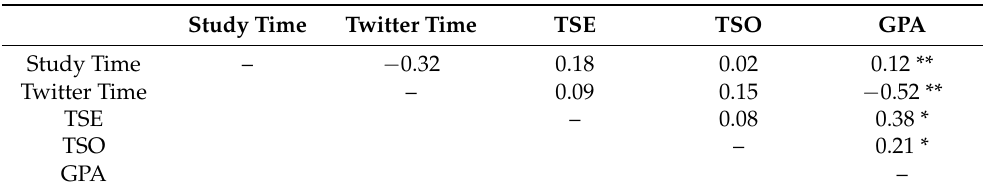
Table 4. Correlation between students ( n = 498) academic performance (i.e., GPA) and other variables and scales. Study Time Twitter Time TSE TSO GPA Study Time – − 0.32 Twitter Time – TSE – TSO – 0.21 *